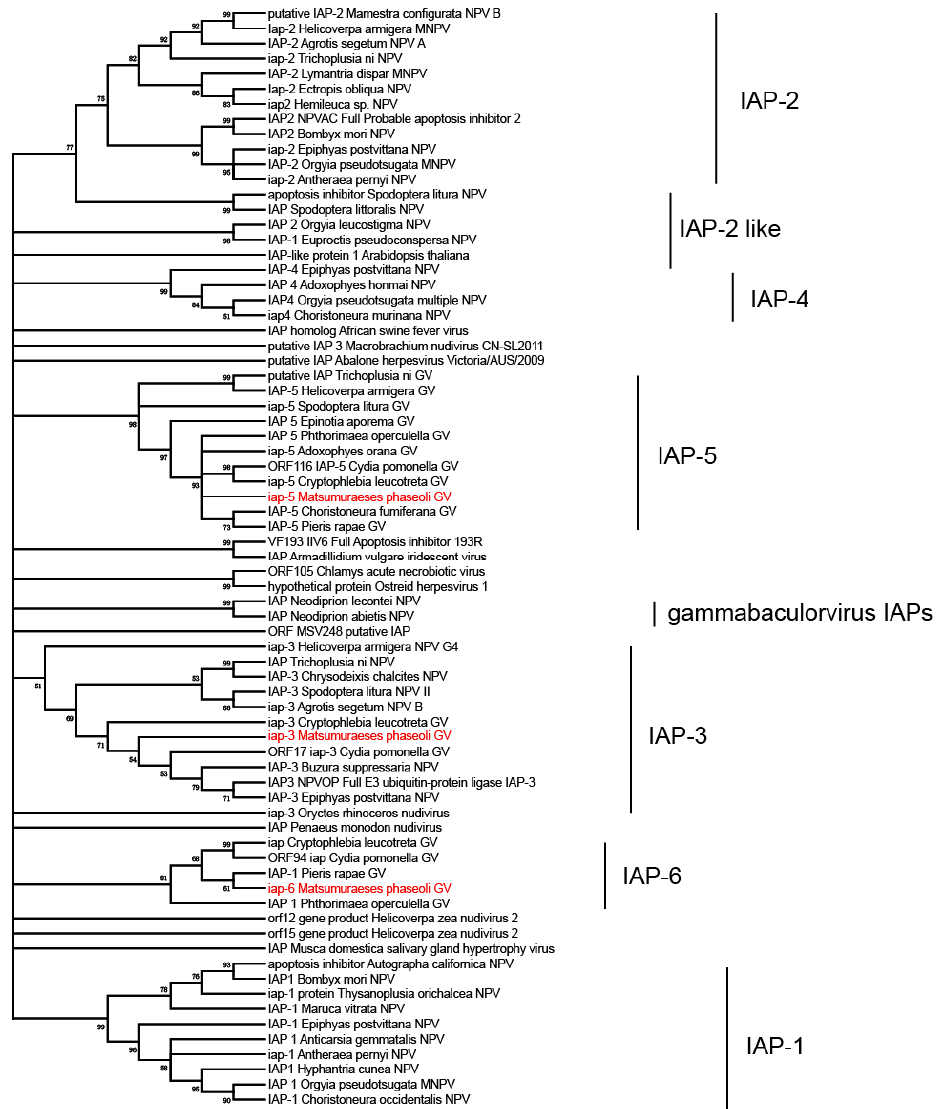
Figure 6. Phylogenetic analysis of the selected viral IAPs. The phylogenetic tree was constructed using the Maximum Likelihood method, using selected baculovirus IAP amino acid sequences with 500 bootstrap values. The initial tree for the heuristic search was obtained by applying the neighbor-joining method to a matrix of pairwise distances estimated using a JTT model. The sequences of IAPs are provided in Table S5. There were 1263 positions in the final dataset. The branches representing MaphGV IAPs are marked in